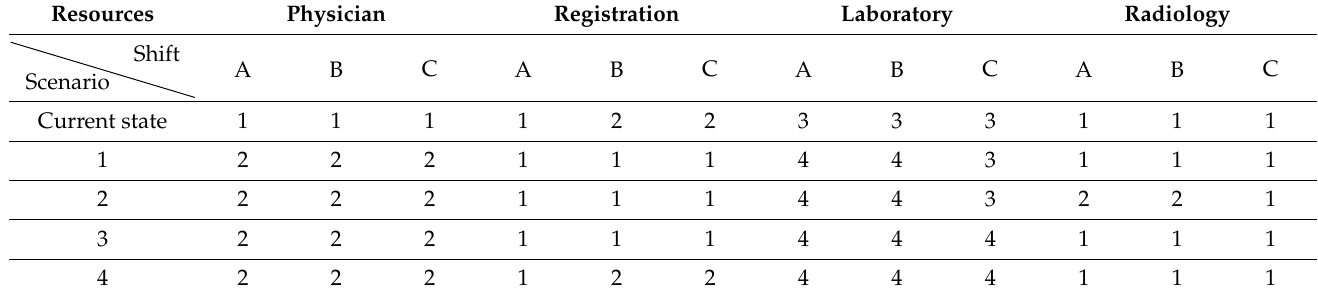
Table 8. The configuration of resources in the proposed scenarios.